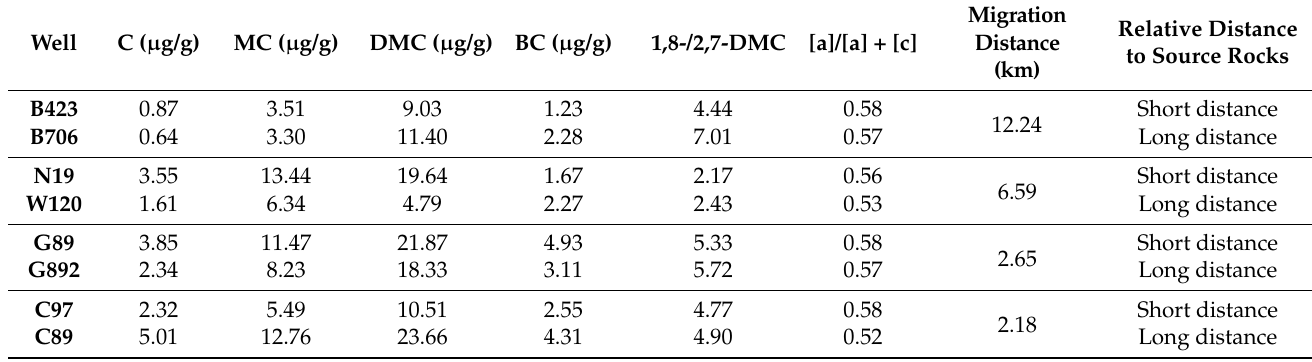
Table 2. Carbazole parameters in the crude oil samples of the Dongying